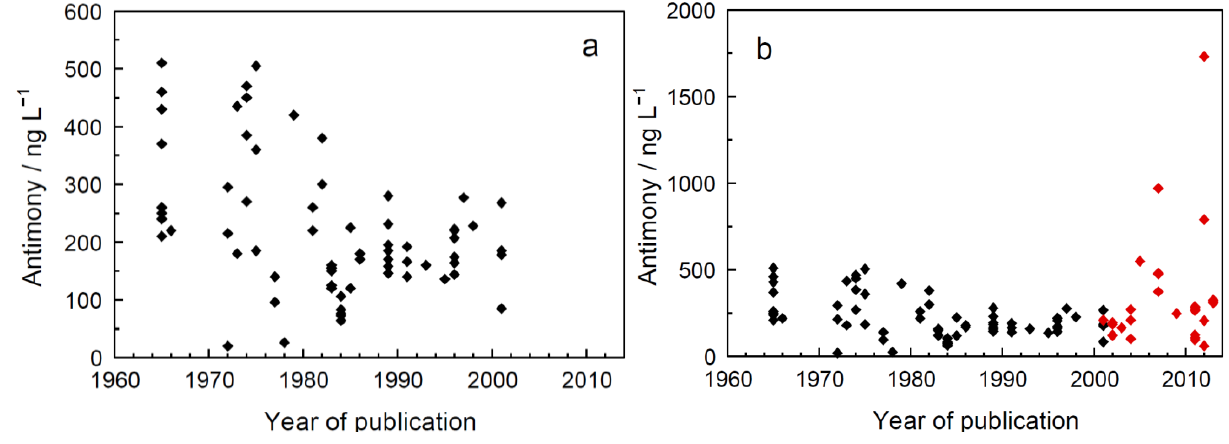
Figure 3. Published antimony concentrations for surface seawater as a function of their year of publication. ( a ) Figure 1 in [14]; ( b ) New values published after 2002 added in red, data from